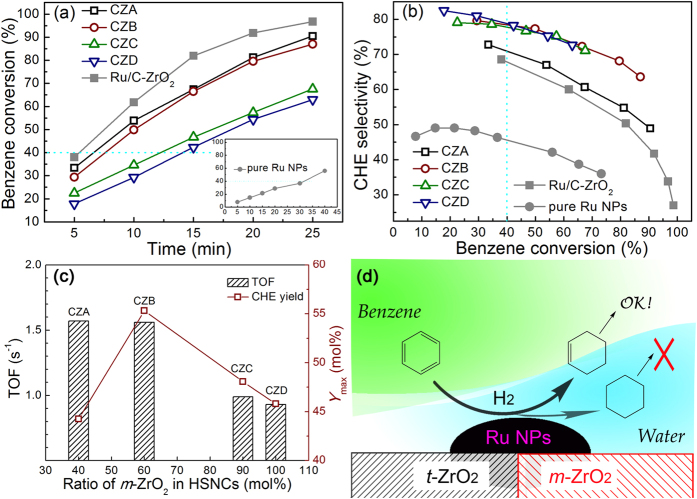
The plots of (a) benzene conversion versus time, and (b) cyclohexene selectivity versus benzene conversion with CZA, CZB, CZC, CZD, Ru/C-ZrO2, and pure Ru NPs catalysts. (c) TOF40 and Ymax of catalysts with different phase mole ratios of m-ZrO2 in HSNCs in benzene-selective hydrogenation to cyclohexene. (d) Catalytic mechanism on Ru/ZrO2 catalysts.